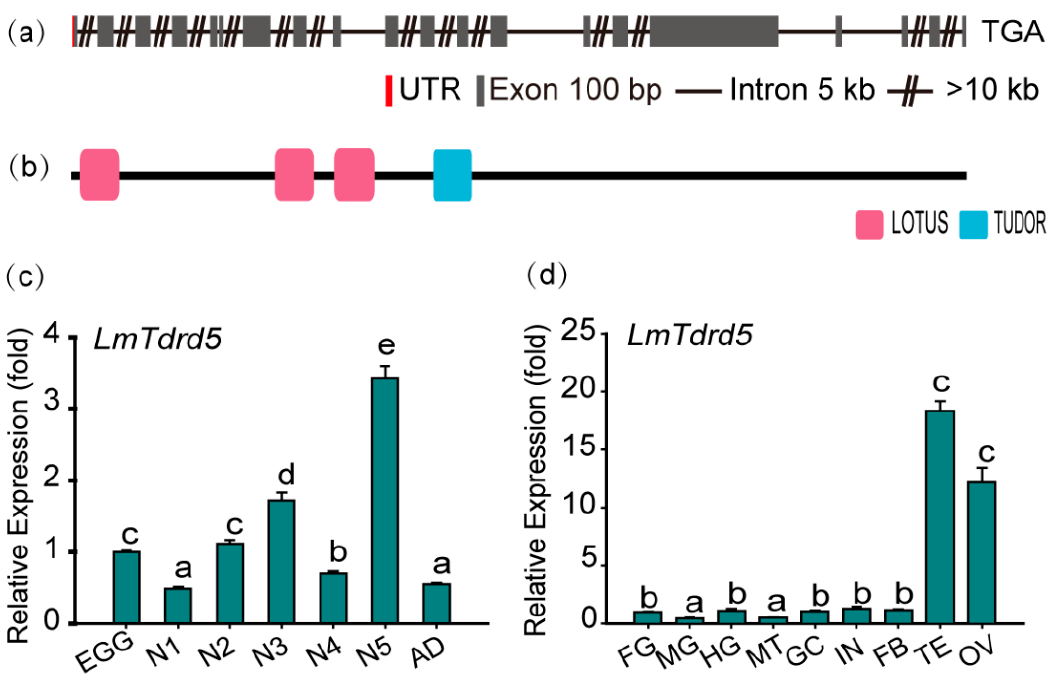
Figure 1. Gene structure and expression profile of LmTdrd5. ( a ) Schematic representation of the exon–intron structure of LmTdrd5. Exons contributed to the coding sequence (CDS) marked in goldenrod, red represents the untranslated region (UTR), the black line denotes an intron, and the double slashes indicate a break of introns. Gene structures were deduced from the analysis on the L. migratoria genome database (http://www.locustmine.org/index.html (accessed on 12 September 2021)). ( b ) LmTDRD5 was analyzed by SMART (Smart.embl-heidelberg.de), showing the four conserved domains marked in two colors. The first three in pink are the LOTUS domains, and the TUDOR domain is in blue. ( c ) LmTdrd5 expression at different locust developmental stages. Egg (EGG), first-instar (N1), second-instar (N2), third-instar (N3), fourth-instar (N4), fifth-instar (N5) nymphs, and adult (AD). ( d ) LmTdrd5 mRNA expression in different tissues of fifth-instar nymphs. FG, foregut; MG, midgut; HG, hindgut; MT, Malpighian tubules; GC, gastric caecum; IN, integument; FB, fat body; TE, testis; OV, ovary. Letters on the bars represent significant differences among the developmental stages or different tissues based on Tukey’s HSD multiple comparison test ( p < 0.05).